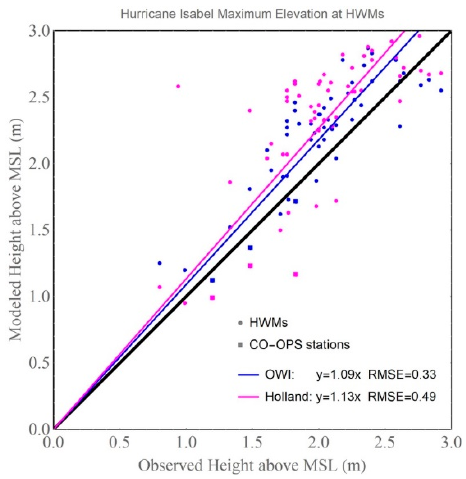
Figure 7. Wave height time series at the NDBC buoys during Hurricane Isabel.